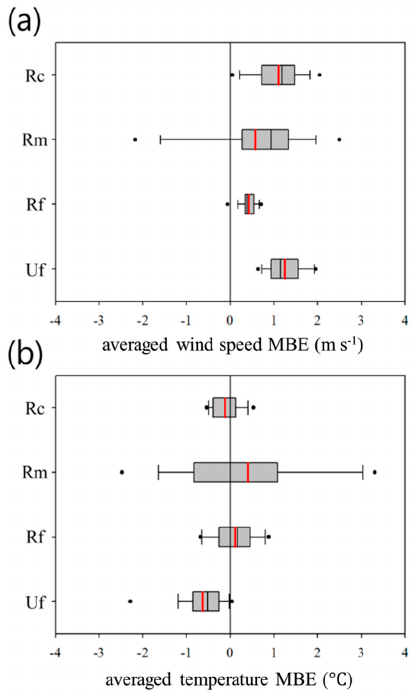
Figure 3. Box Plots of the ( a ) WEs and ( b ) TEs for four categories. In each box plot, upper and lower black circles indicate the outliers, the bars above and below a box, respectively, indicate the upper and lower extremes, and upper, middle, and lower segments of a box, respectively, indicate the upper quartile, median, and lower quartile. The red line in each box plot represents the average of the mean bias error for the category.